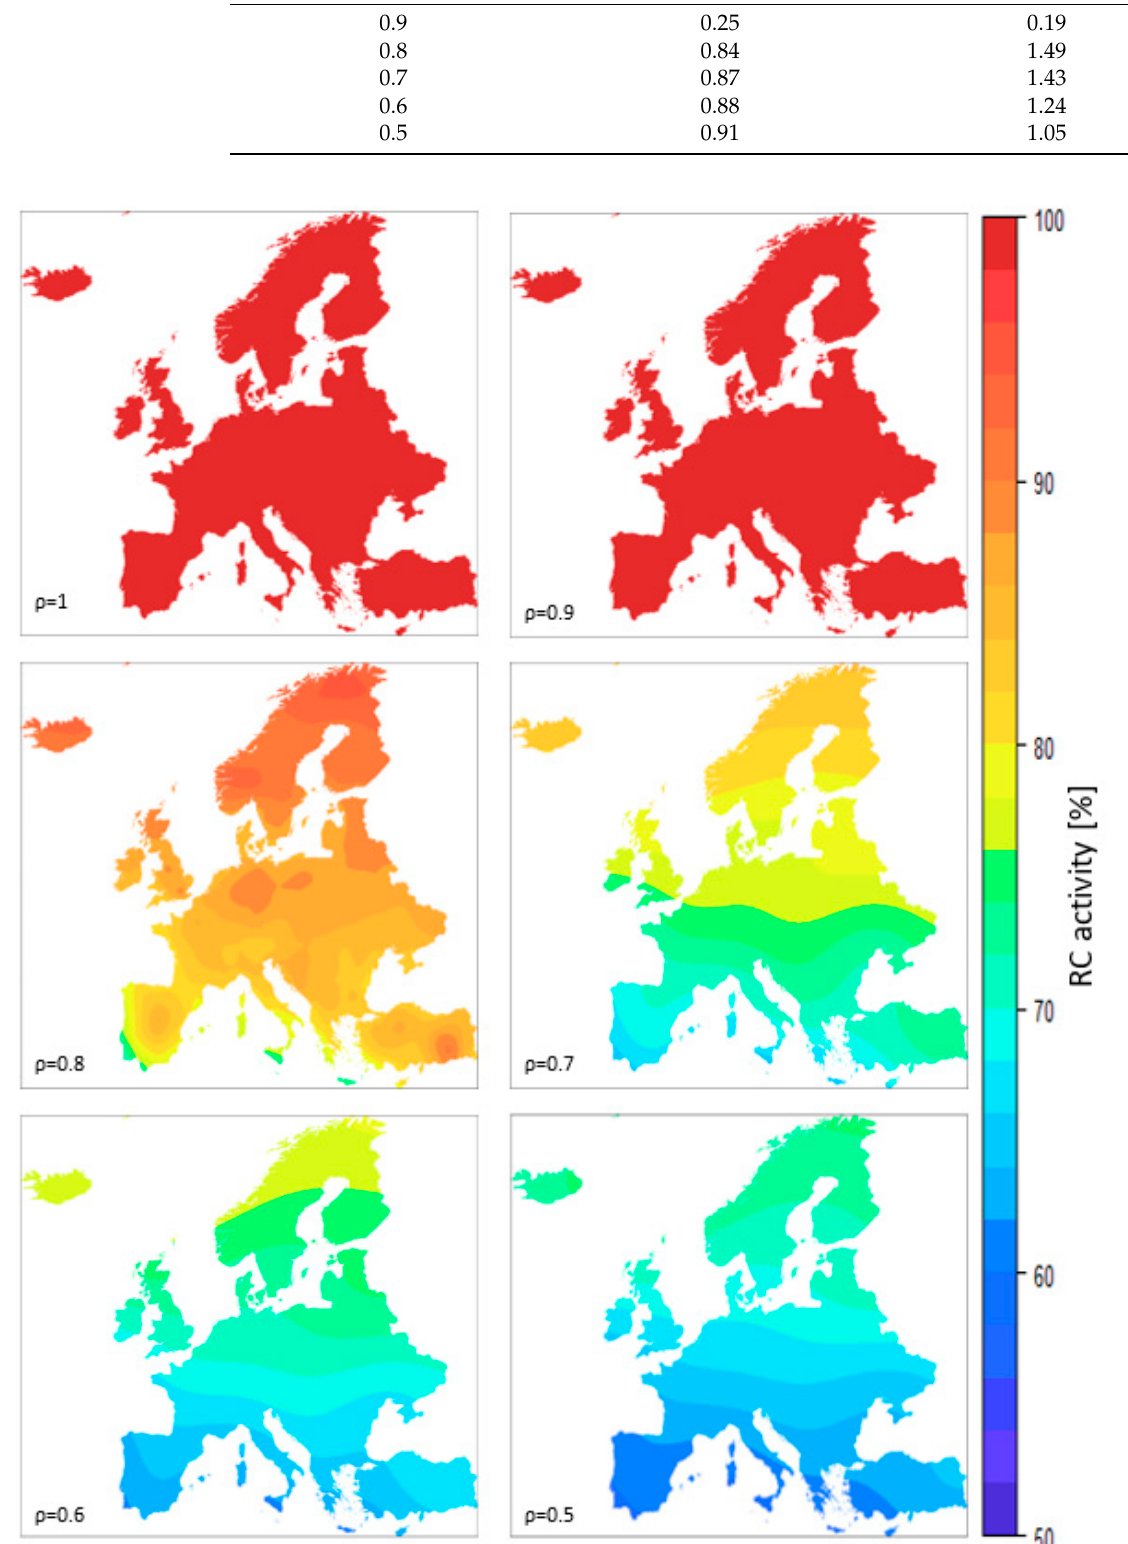
Figure 6. Map of RC activity (%) for six values of solar radiation